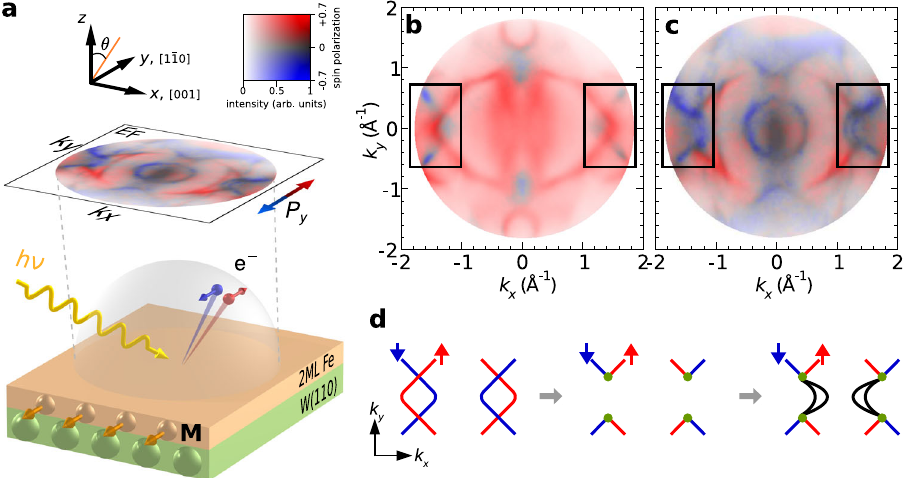
Fig. 1 | Fermiarcs in a 2D topologicalferromagnet.a Experimentalgeometryfor the spin-, orbital-, and momentum-resolved photoelectron study of the Fermi surface. The magnetization M and the spin polarization P y are oriented in-plane along the y axis, i.e., the crystallographic ½ 1 (cid:1) 10 (cid:2) direction. b , c Spin-resolved pho- toemission momentum maps at the Fermi energy E F for b 12 MLs and c 2 MLs Fe fi lms grown on W(110), measured with a photon energy of h ν =50eV for a sample